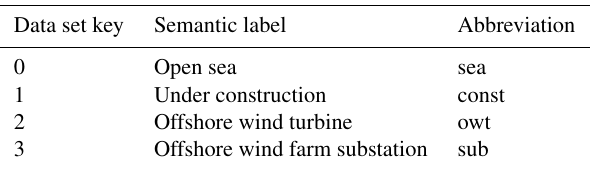
Table 4. Mapping of the key in integer format (as used in the data set files) to semantic labels and their